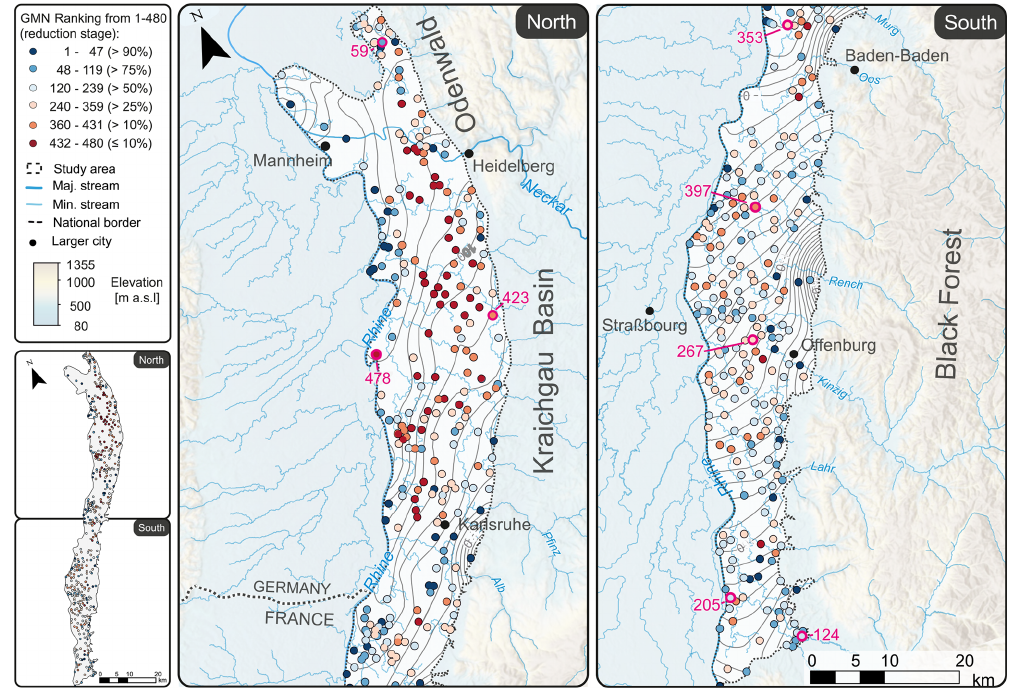
Figure 3. QR-based ranking of groundwater monitoring wells based on hydrograph information content, from 1 (high information content; blue) to 480 (redundant; red). The reduction stage at which the respective wells are removed is indicated in parentheses. The hydrographs of the highlighted wells (pink) are shown in Fig.